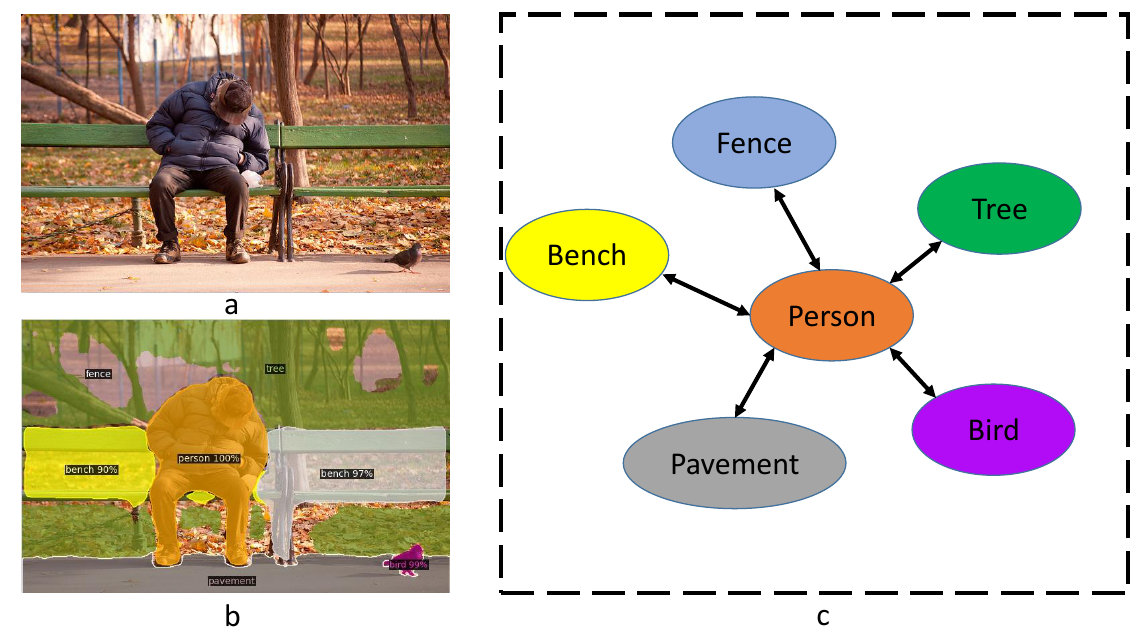
Figure 3. Example of building graph model. Given the input image ( a ), Detectron2 can detect the region and categories of objects and ( b ) is the segmentation result. Based on the detection information, we build a graph ( c ) over the corresponding